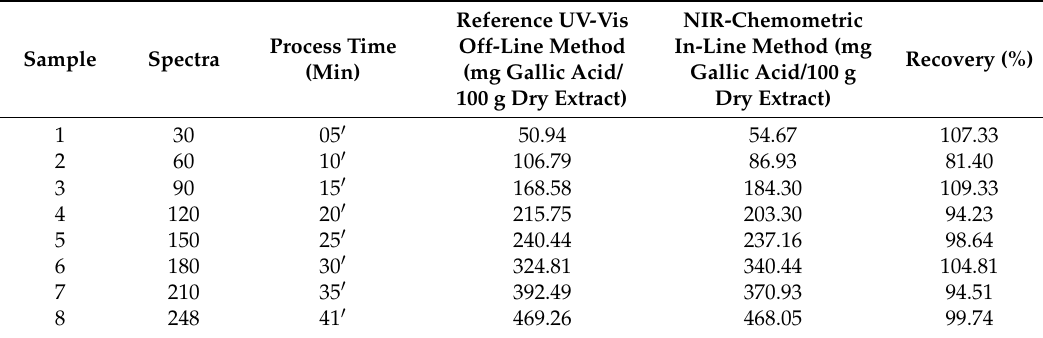
Table 1. Measured and near-infrared (NIR) predicted dry extract